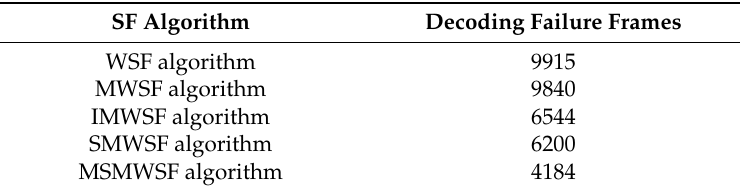
Table 2. Five algorithms for decoding failure frames.